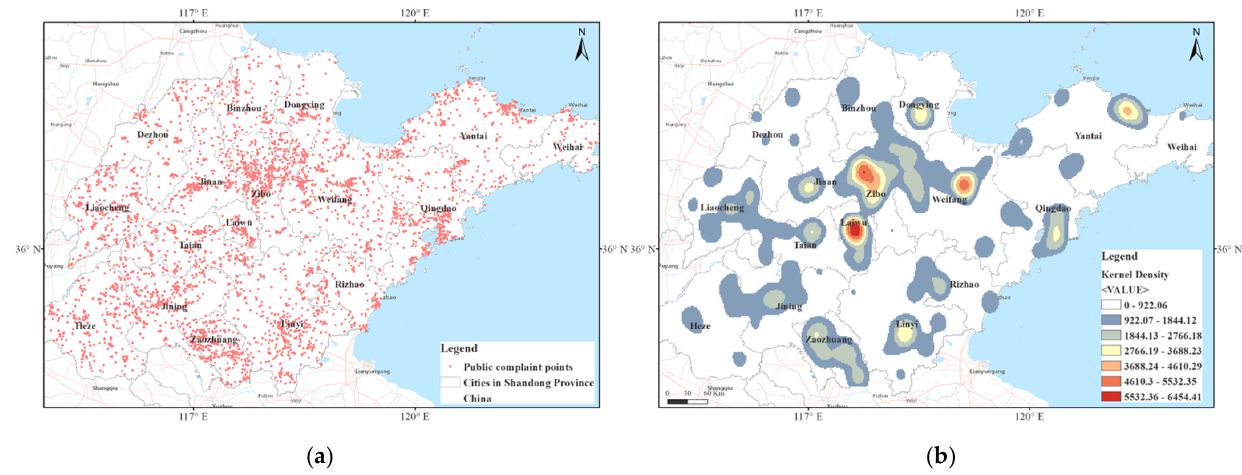
Figure 4. Distribution of air pollution complaint data in Shandong Province from 2012 to 2018 ( a ) and kernel density map of complaint location ( b ).